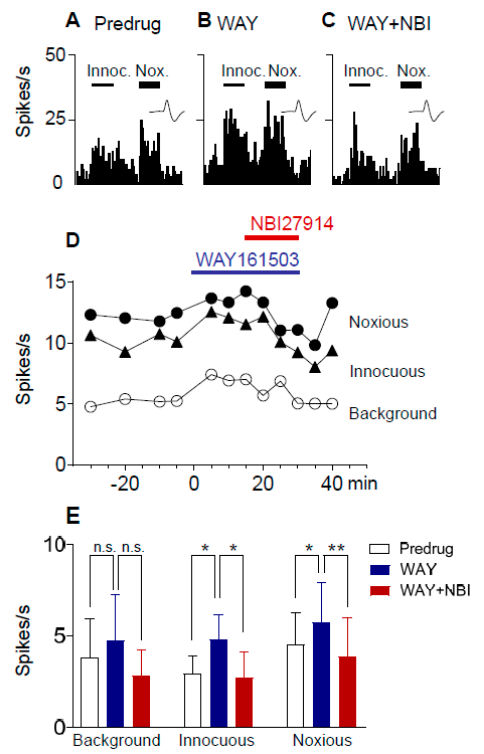
Figure 5. Excitatory effects of a 5-HT 2C R agonist (WAY161503) were blocked by a CRF1 receptor antagonist (NBI27914) in a neuropathic pain model. CeA neurons were recorded in SNL rats 4 weeks after SNL surgery. Background activity and evoked responses to innocuous (100 g/6 mm 2 ) and noxious (500 g/6 mm 2 ) stimulation of the left hindpaw are shown. ( A – C ) Peristimulus time histograms show action potentials (spikes) per second in one individual CeA neuron before ( A ) and during application of WAY161503 alone (100 µM concentration in microdialysis fiber; 15 min; ( B )) and during coapplication of WAY161503 with NBI27914 (100 µM concentration in microdialysis fiber; 15 min; ( C )) into BLA. ( D ) Time course data showing the increase in activity by WAY161503 (100 µM concentration in microdialysis fiber; 15 min) and reversal by NBI27914 (100 µM concentration in microdialysis fiber; 15 min) administered into the BLA. ( E ) Summary of drug effects in SNL rats ( n = 5 neurons). n.s., not significant; *, ** p < 0.05, 0.01 Bonferroni post hoc tests, respectively (repeated measures ANOVA, see results section).